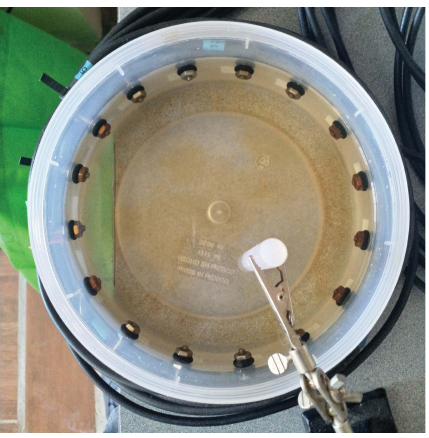
Figure 2. Test unit (vessel) with 16 stainless steel 304-caliber electrodes.